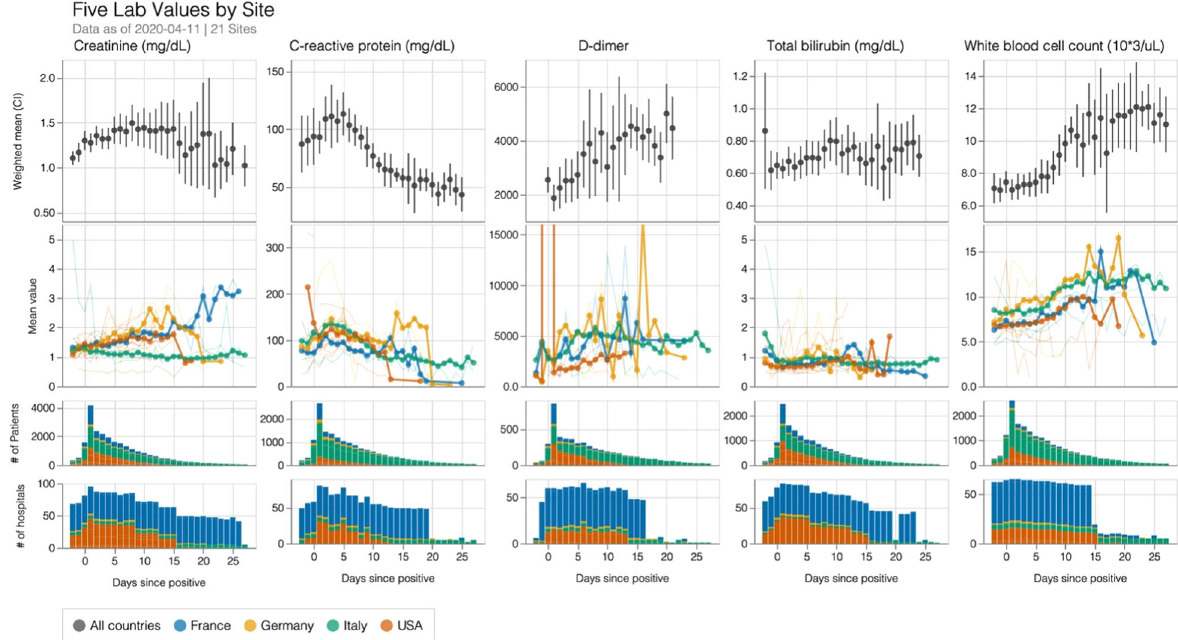
Fig. 3 Laboratory tests representative of renal function (creatinine), systemic in fl ammation (C-reactive protein), coagulopathy (D-dimer), liver function (total bilirubin), and immune response (white blood cell count) visualized relative to date of diagnosis of COVID-19. The top row shows weighted means and 95% con fi dence intervals across all patients. The second row shows unweighted country- (thick lines) and site-level (thin lines) means. The third and fourth rows show the number of patients and sites, respectively, contributing laboratory tests of each type on a given